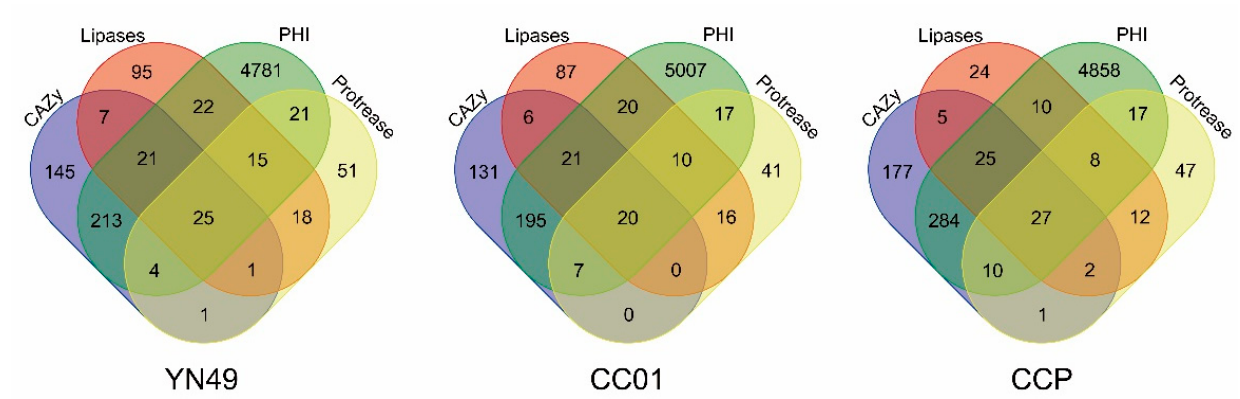
Figure 6. Venn diagram showing the overlap of different secreted gene categories with genes relevant to fungal patho- genicity.